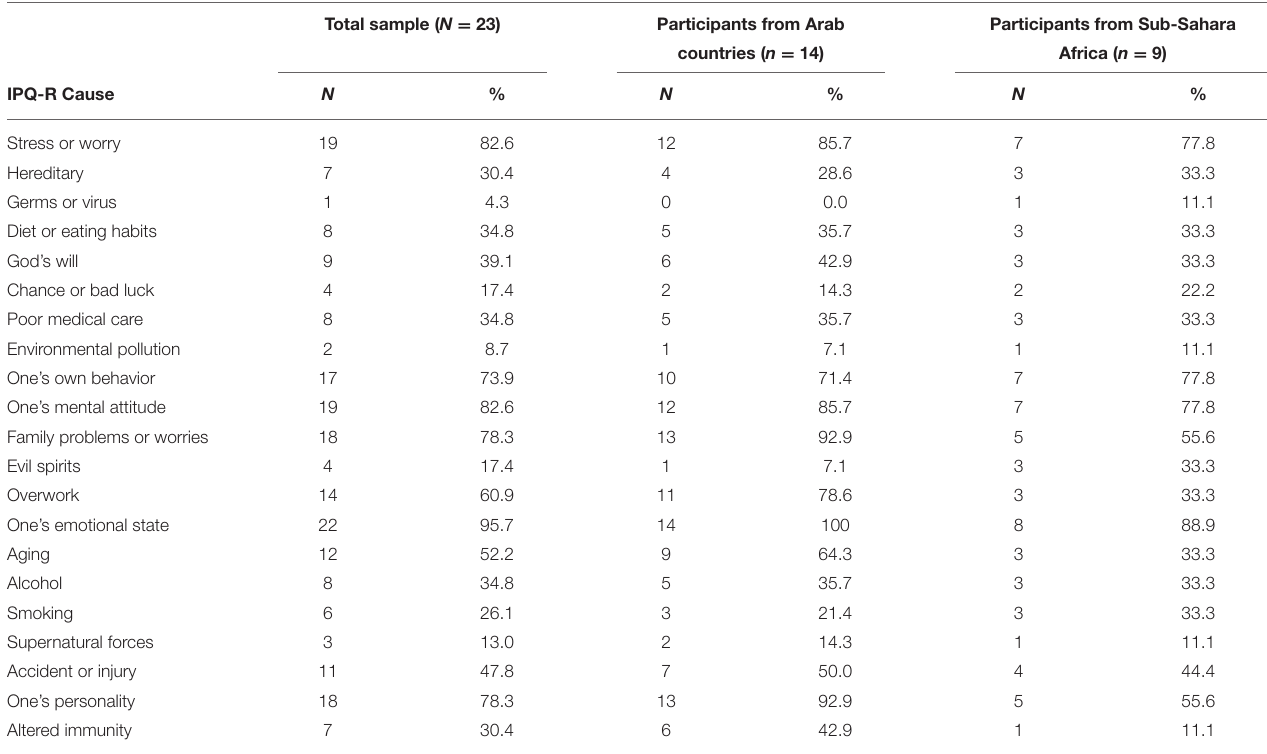
TABLE 3 | Causes of PGD symptoms assessed with the Revised Illness Perception Questionnaire